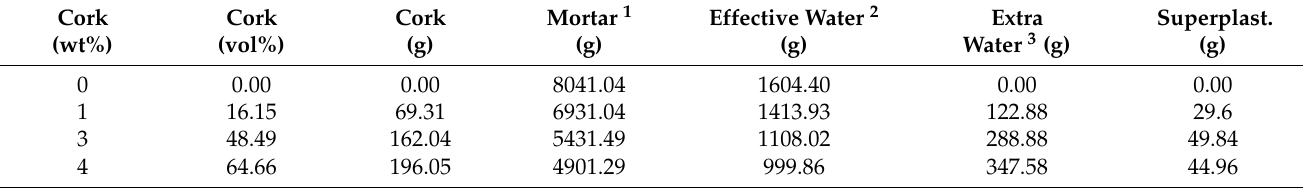
Table 1. Mix design of mortars containing increasing content of cork waste (from 0 wt% to 4